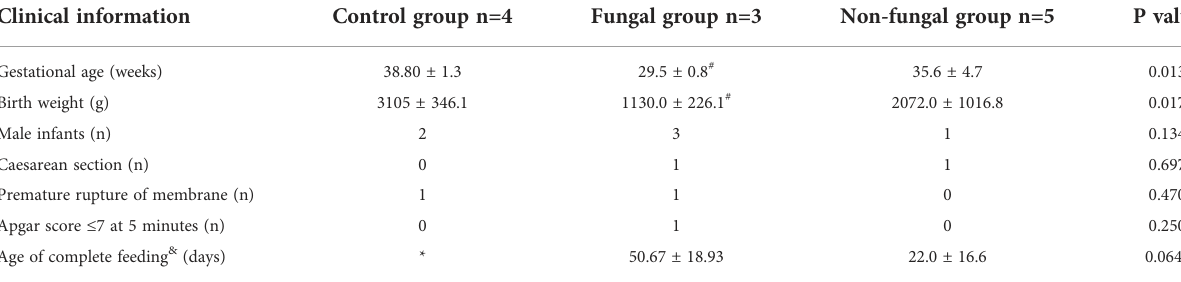
TABLE 1 Comparison of clinical data among healthy volunteers, infants with fungal infection and infants without fungal infection (n=12). Clinical information